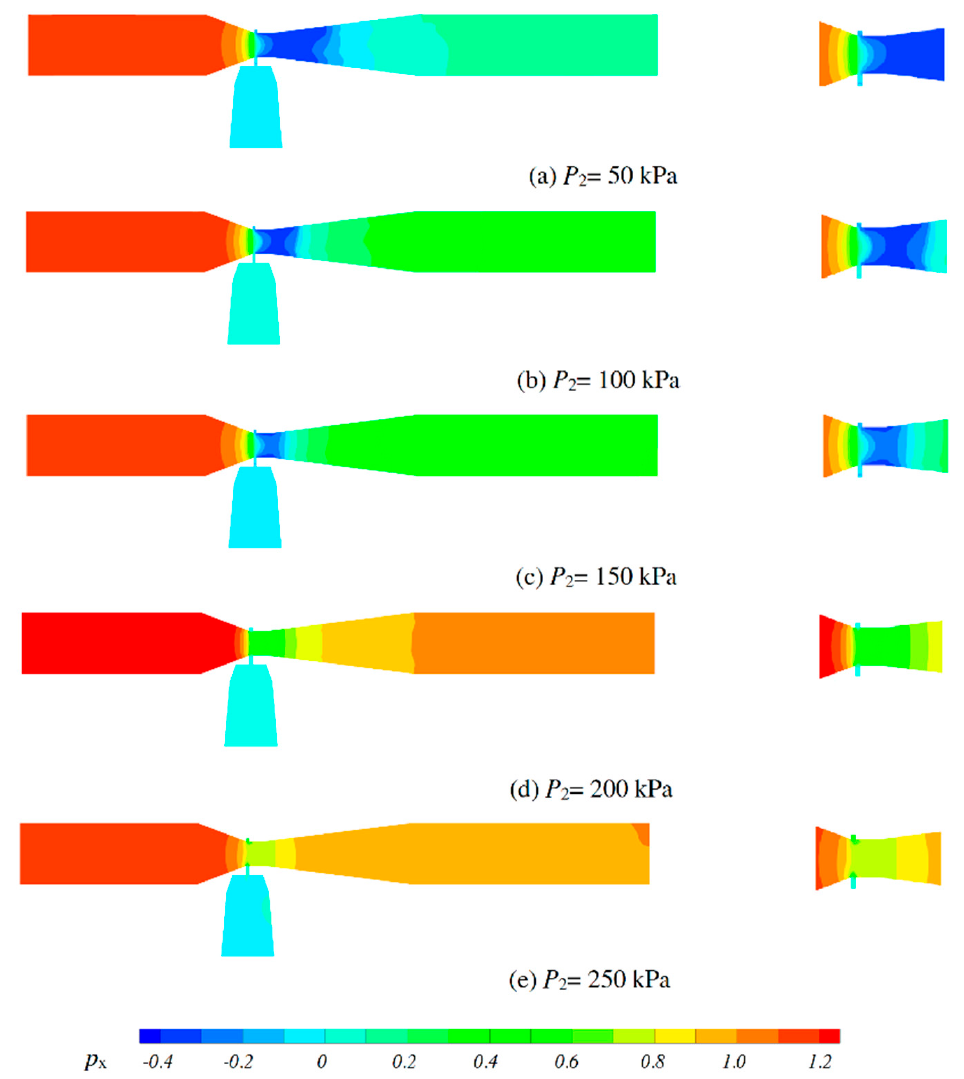
Figure 6. Local pressure ratio contours in the z = 0 section.